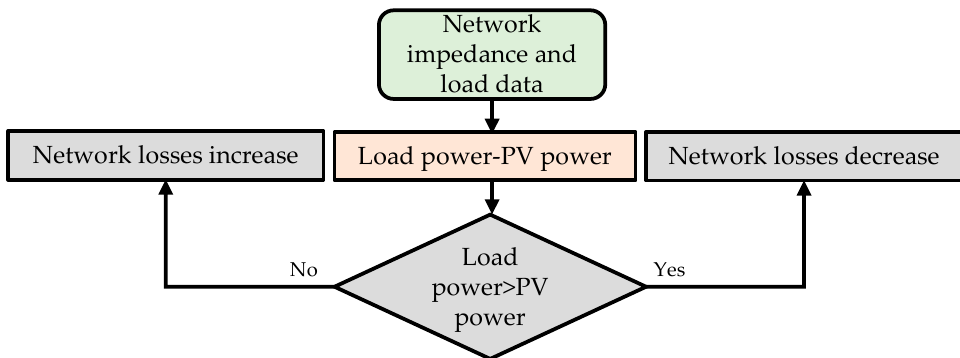
Figure 9. Network loss variation with respect to load and PV power.